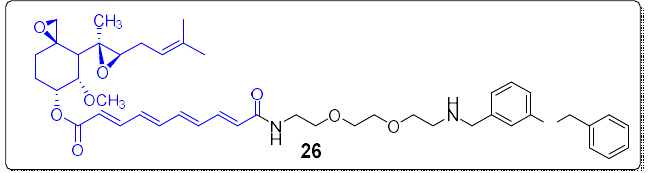
Figure 8. Fumagillin conjugated to TK-105.